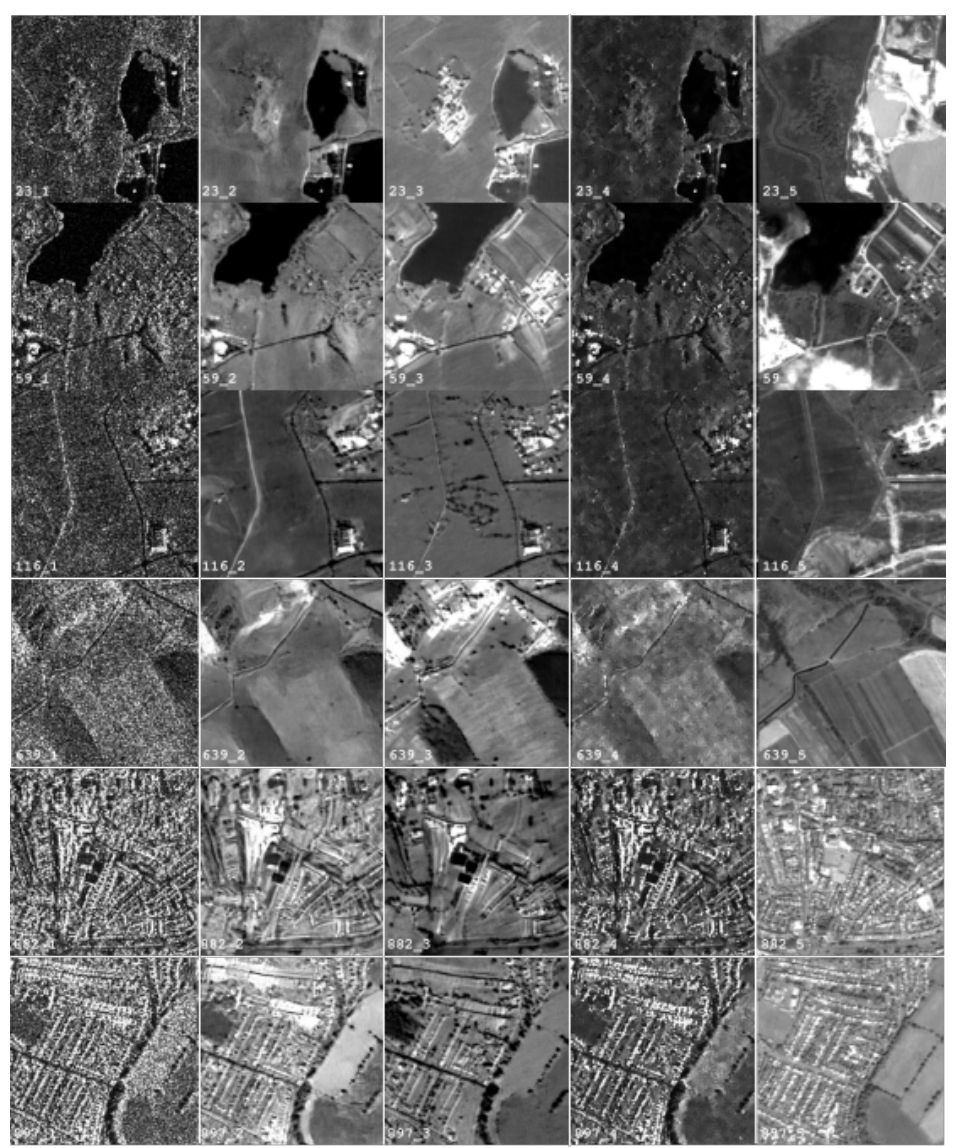
Figure 4. Results from the CycleGAN network compared to other approaches. First column: original SAR image, second: CycleGAN result, third: DRIT result, fourth: NL-SAR result [34], last: optical